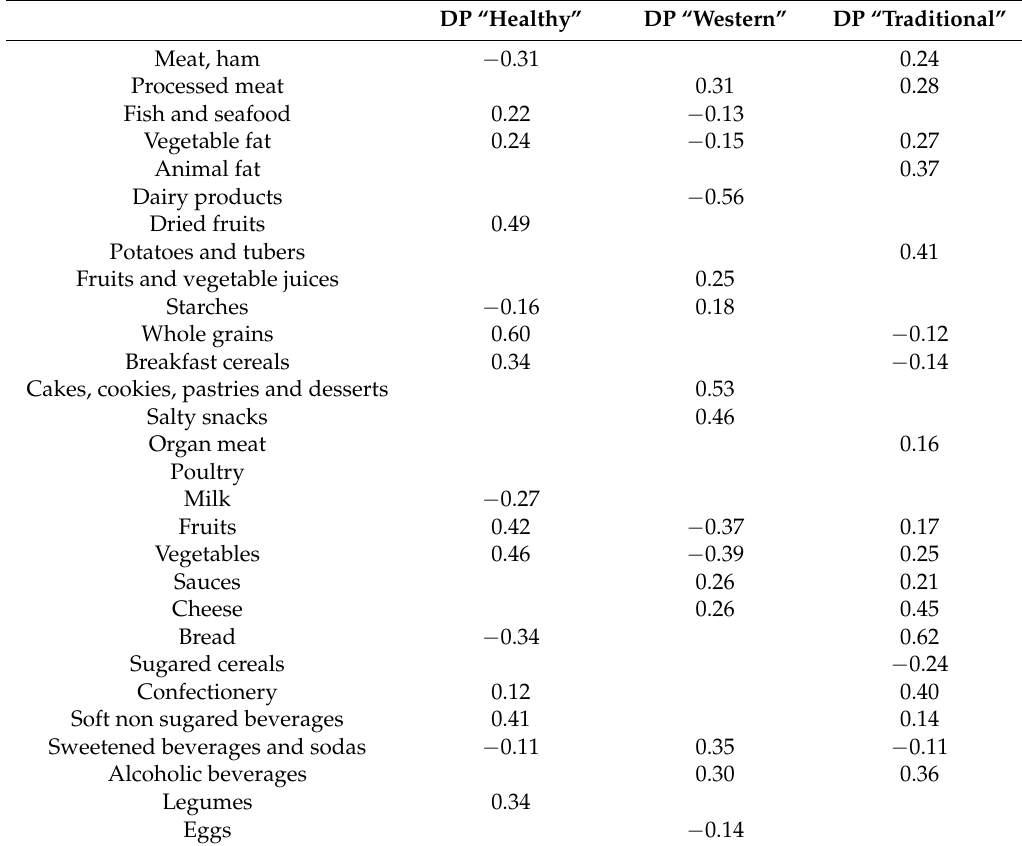
Table 2. Loadings of food groups in dietary pattern scores ( n = 44,350) (see Supplementary Materials for definitions of food